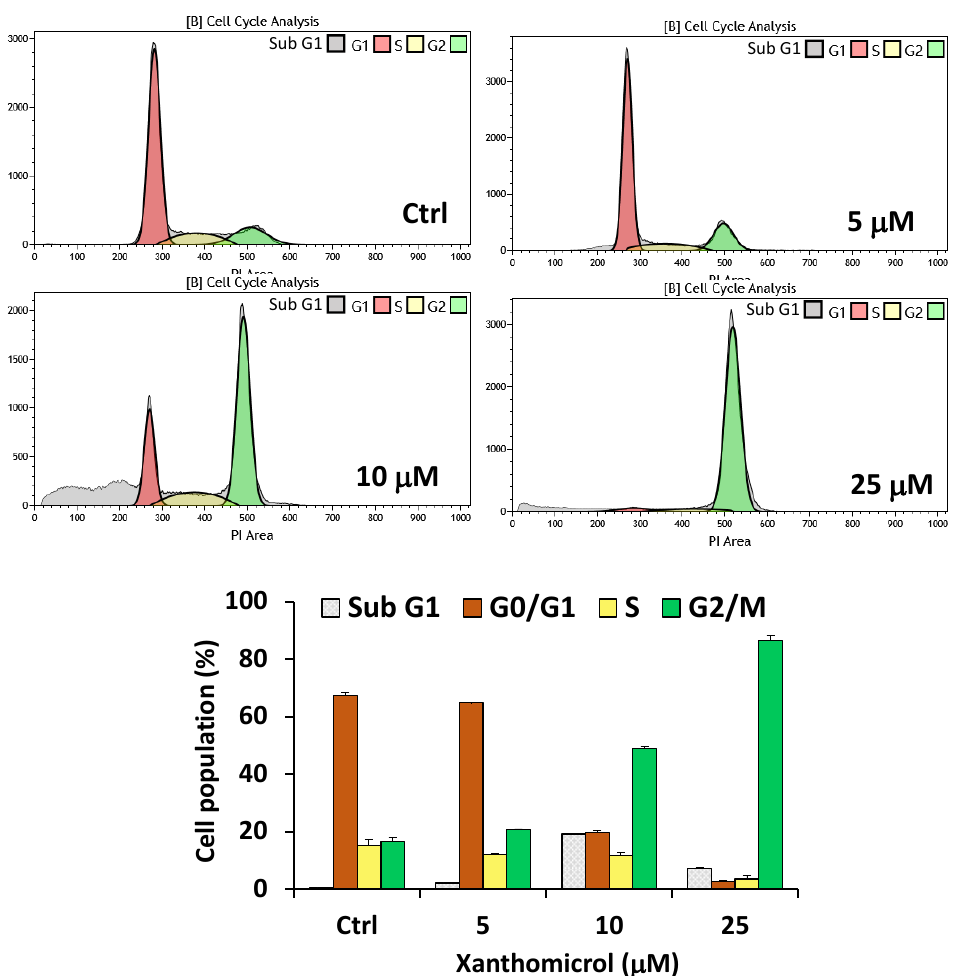
Figure 4. Flow cytometric analysis of the cell cycle distribution of control HeLa cells (Ctrl) and cells treated for 24 h with xanthomicrol 1 at concentrations of 5, 10, and 25 µ M. Percentage values of the HeLa cells in cell cycle patterns (sub G1, G0/G1, S, and G2/M phases) are reported in the lower panel.